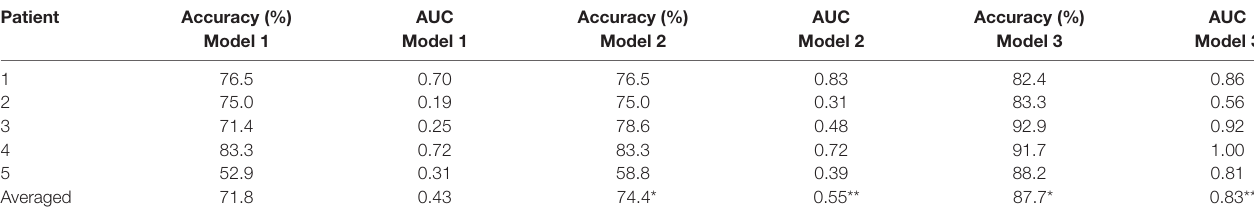
TABLE 3 | Summary of classification accuracy and area under curve using different classification